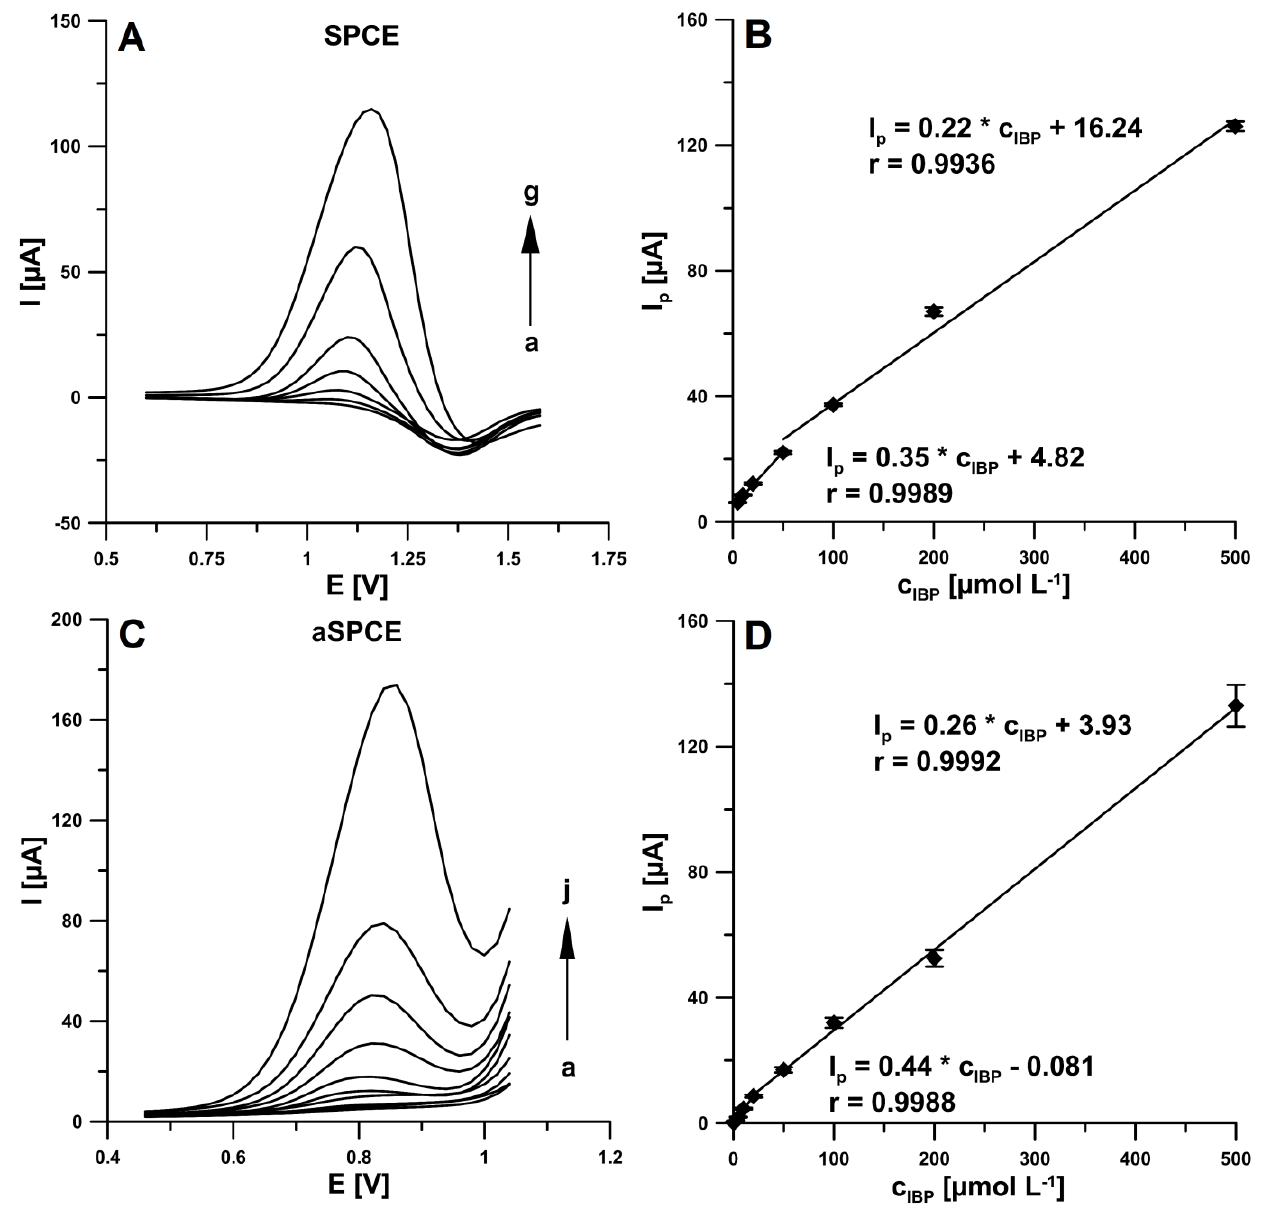
Figure 4. ( A ) DPVs recorded at the SPCE in 0.25 M acetate buffer solution of pH 4.5 ± 0.1 containing increasing concen- trations of IBP: (a) 5.0, (b) 10.0, (c) 20.0, (d) 50.0, (e) 100.0, (f) 200.0, (g) 500.0 µM. ( B ) Calibration plot of IBP at the SPCE. ( C ) DPVs recorded at the aSPCE in 0.25 M acetate buffer solution of pH 4.5 ± 0.1 containing increasing concentrations of IBP: (a) 0.5, (b) 1.0, (c) 2.0, (d) 5.0, (e) 10.0, (f) 20.0, (g) 50.0, (h) 100.0, (i) 200.0, (j) 500.0 µM. ( D ) Calibration plot of IBP at the aSPCE. Stirring solution of 45 s under open circuit. The DPV parameters: ∆ E A of 150 mV, ν of 200 mV s − 1 and t m of 25 ms. Table 2. Summary of IBP determination in pharmaceutical tablets using DPV and aSPCE. Tablets Label Value